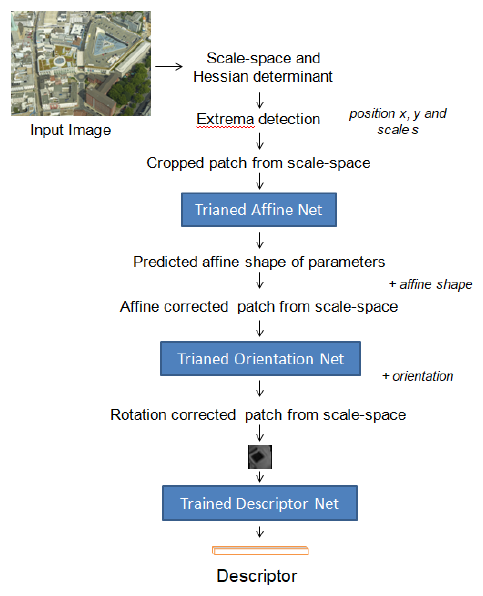
Figure 6. Feature detection and descriptor